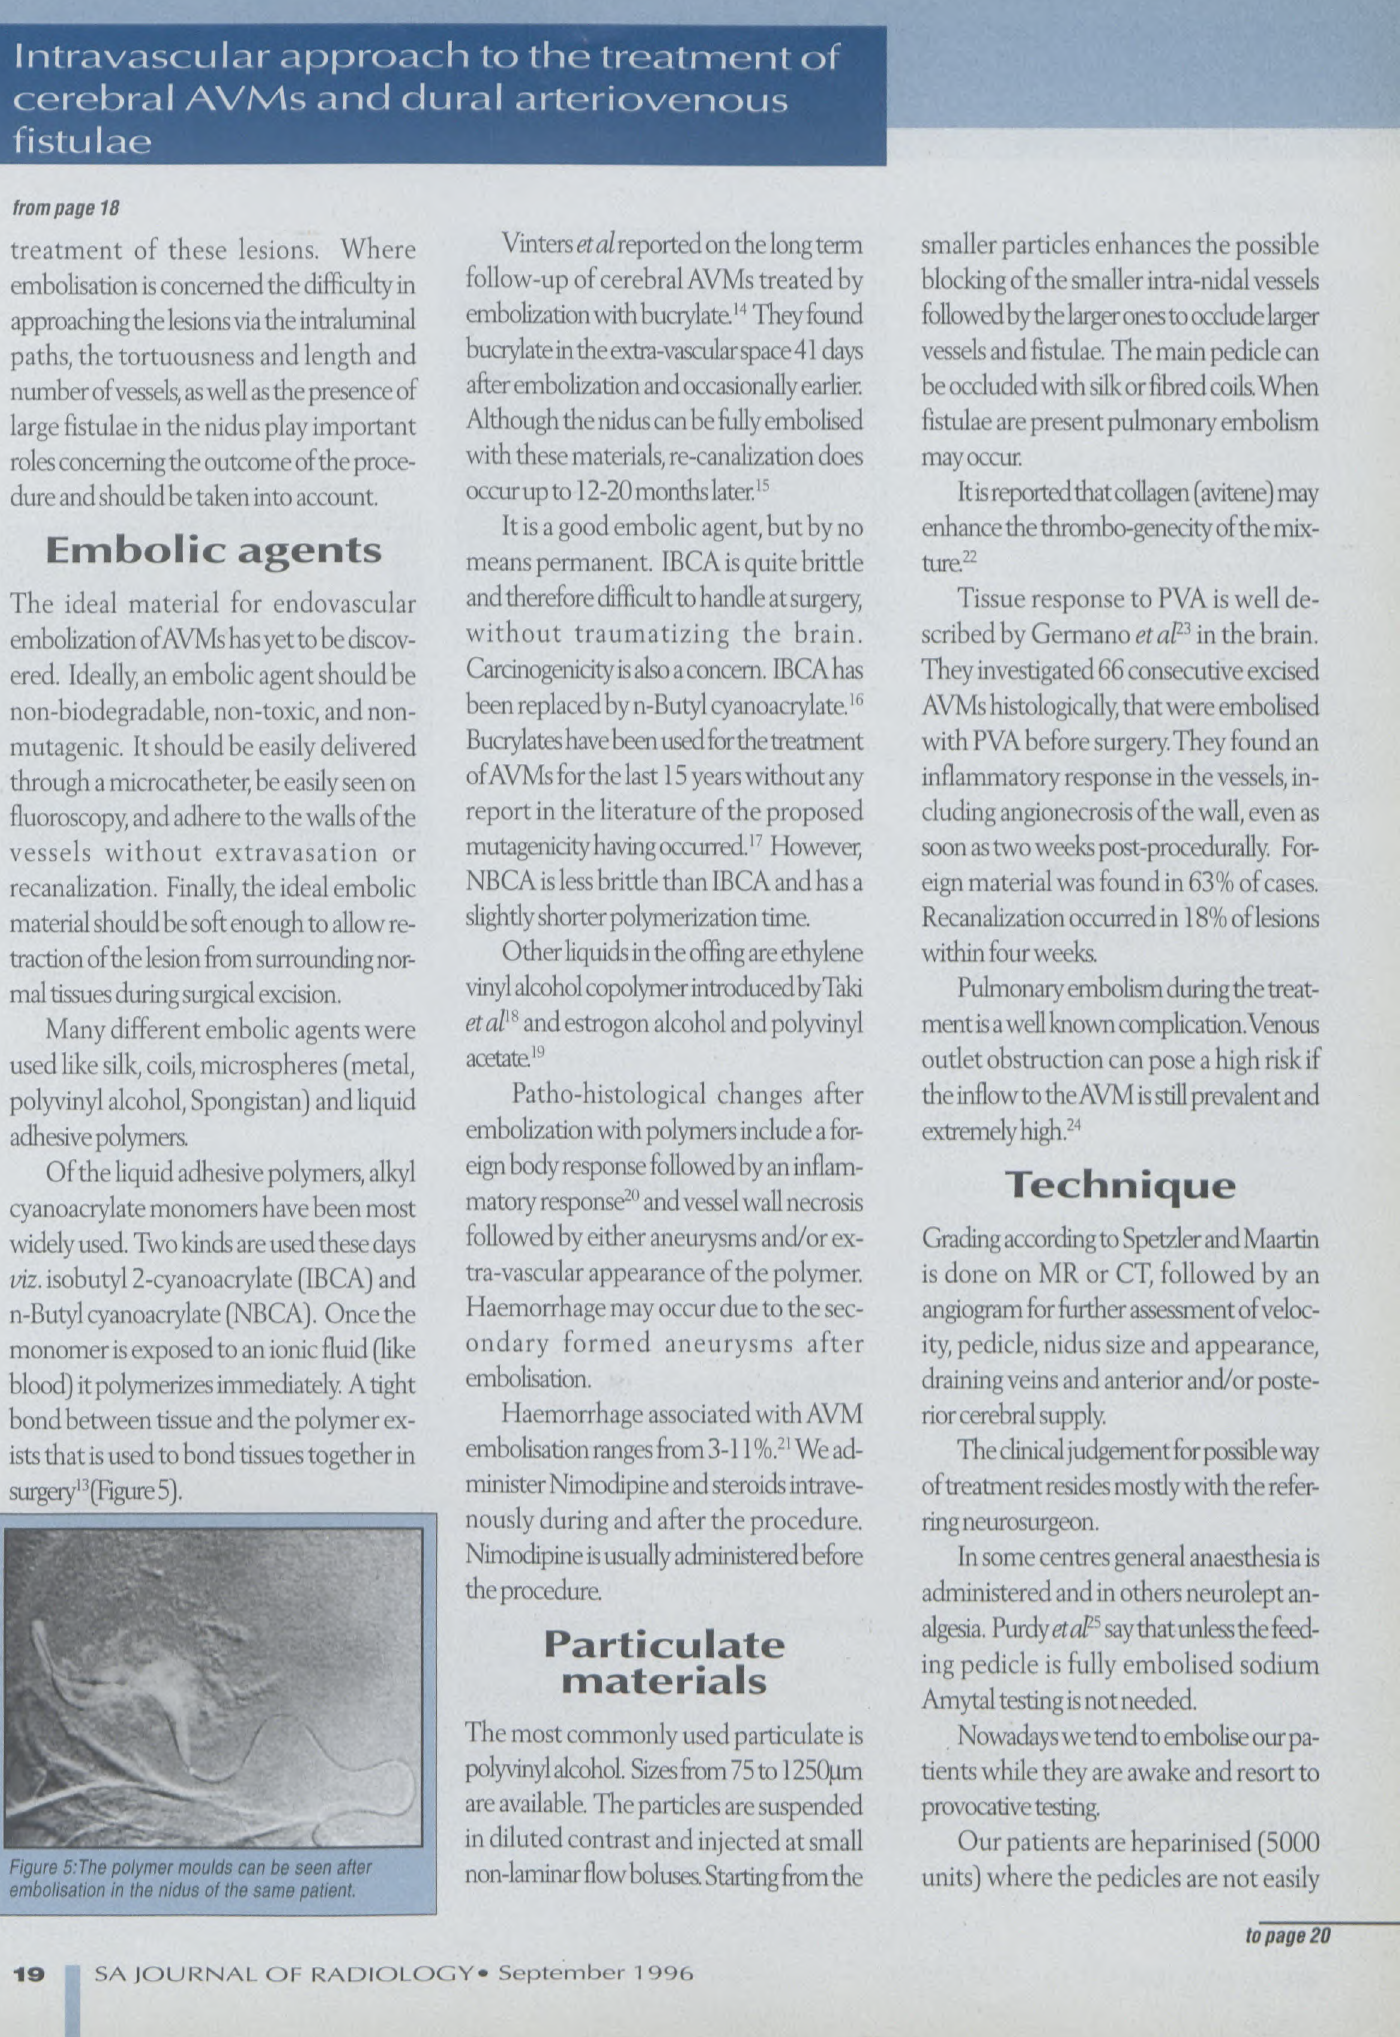
Figure 5:The polymer moulds can be seen after embolisation in the nidus of the same